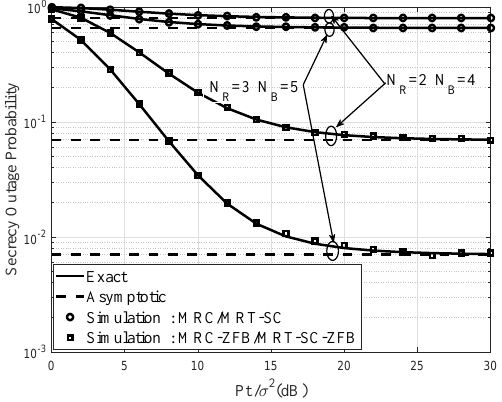
Figure 5. Exact and asymptotic secrecy outage probabilities for the MRC/MRT-SC and MRC-ZFB/MRT-SC-ZFB schemes under Scenario II when γ J = 10 dB and different values N R and N B